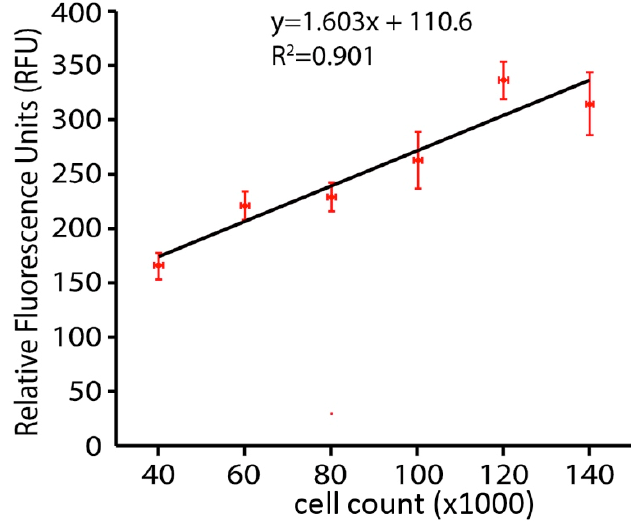
Figure 1. Linear relationship between cell number and calcein fluorescence.